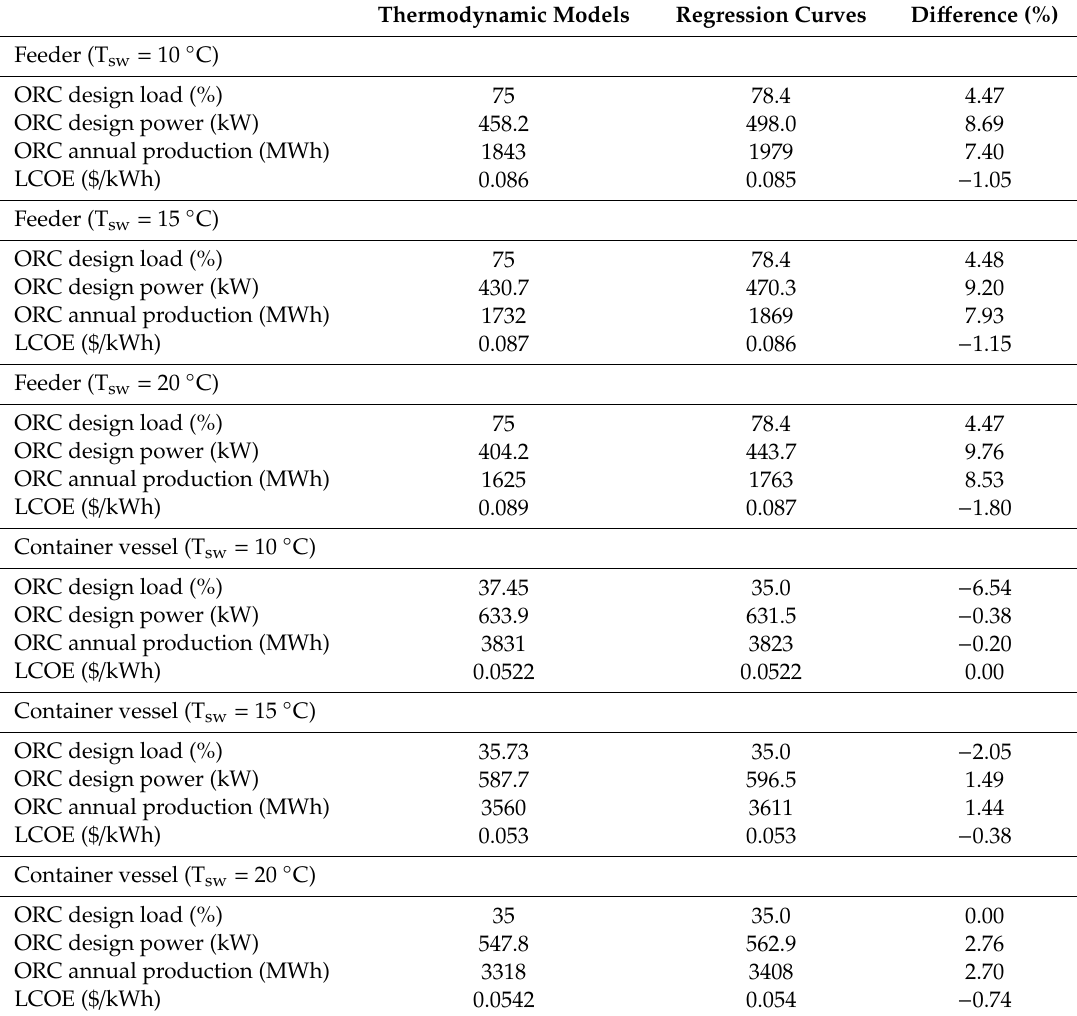
Table 7. Comparison between the solutions attained using the thermodynamic models and the regression curves (model #1): energy production maximization